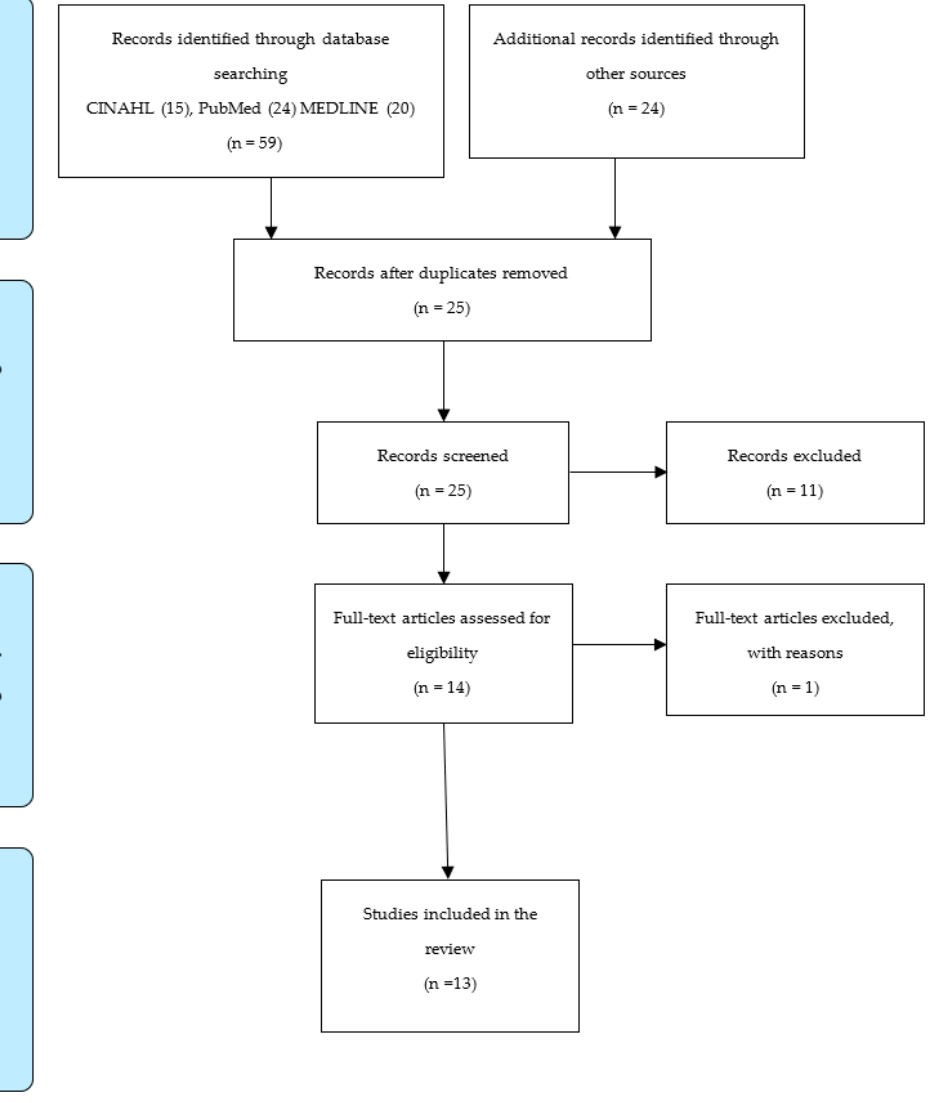
Figure 1. PRISMA flow diagram.